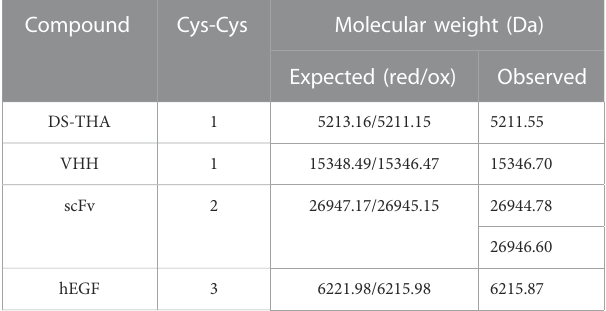
TABLE 2 Oxidation state analysis of the produced pepteins. TABLE 3 Results of hEGF activity